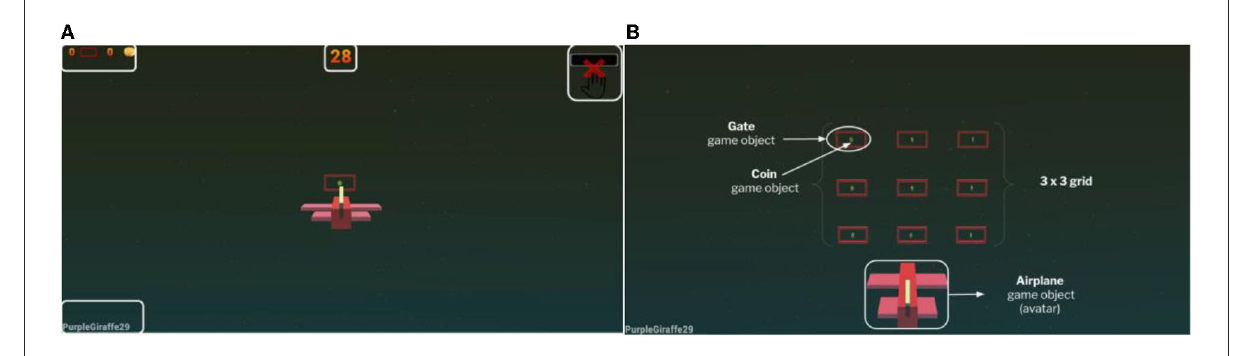
FIGURE3 (A) Game scene of the main game version and (B) explanatory scene of the game objects in the main